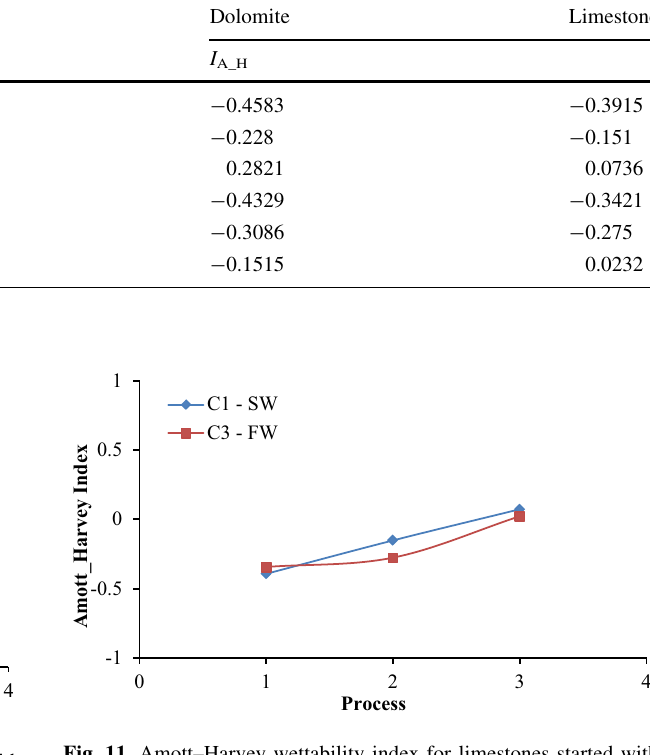
Fig. 10 Amott–Harvey wettability index for dolomites started with SW and FW